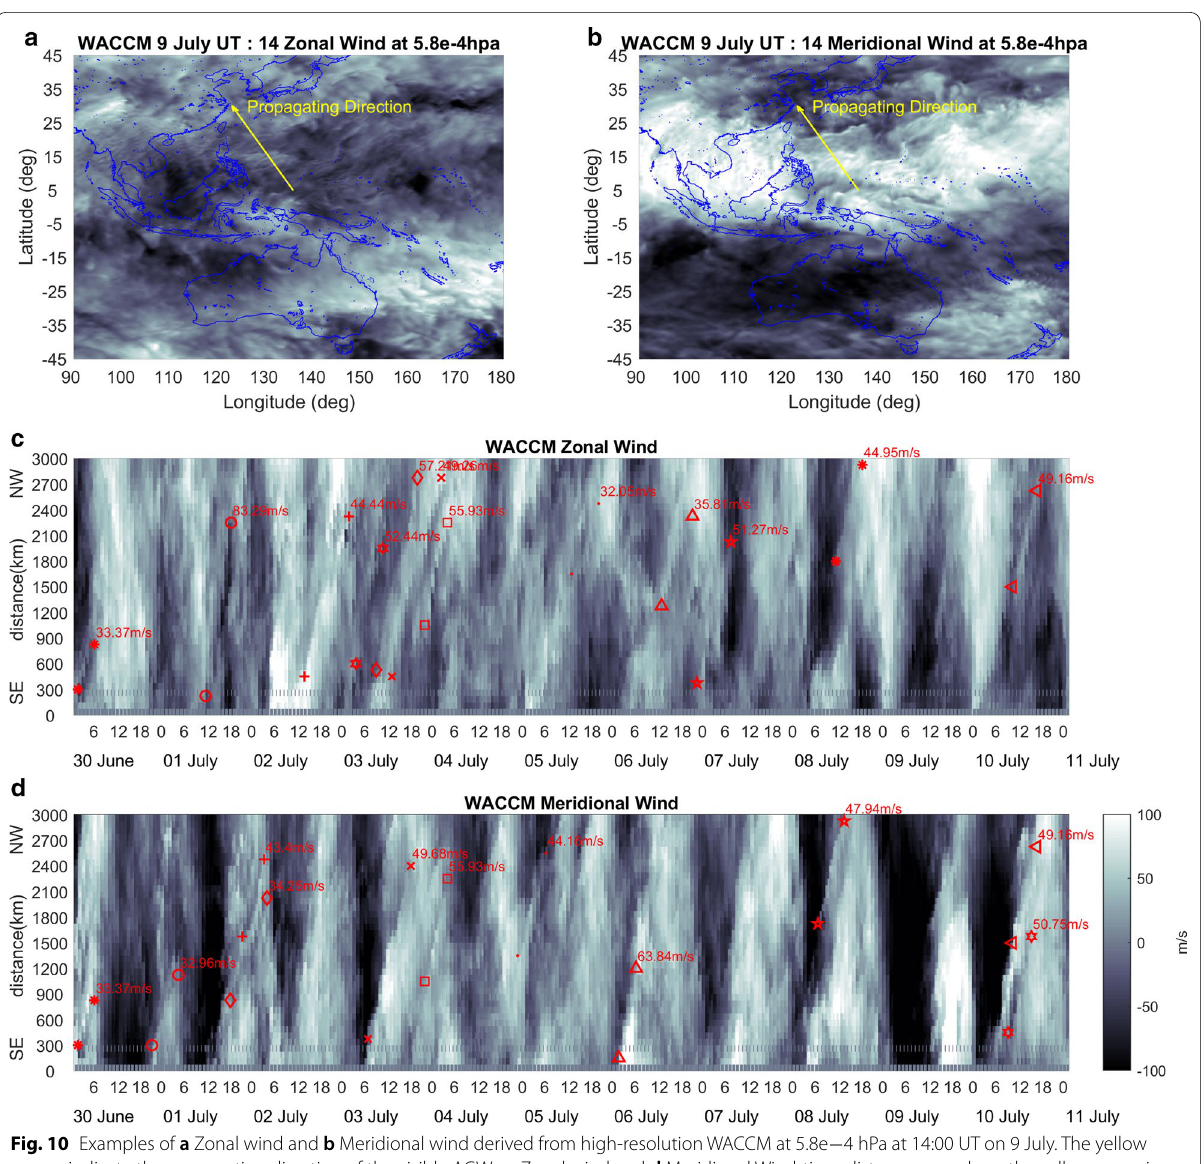
Fig. 10 Examples of a Zonal wind and b Meridional wind derived from high‑resolution WACCM at 5.8e arrows indicate the propagation direction of the visible AGWs. c Zonal wind and d Meridional Wind‑time‑distance map along the yellow arrow in a and b , respectively. Each pair of the red symbols indicates an AGWs event. The numbers above the symbols represent the phase velocity of the